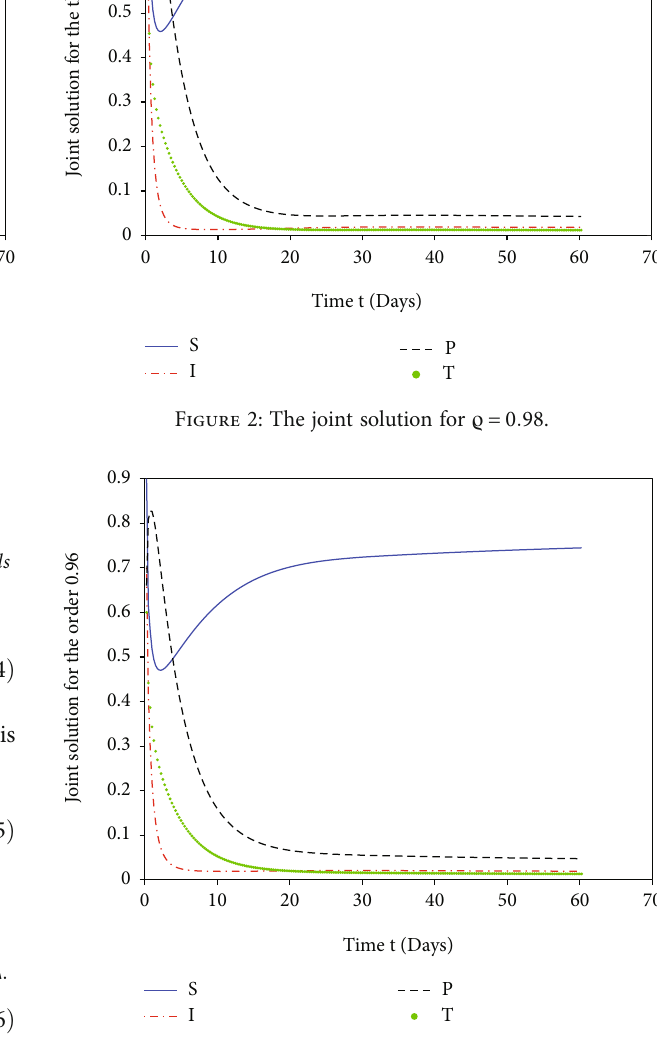
Figure 3: The joint solution for ϱ = 0 : 96